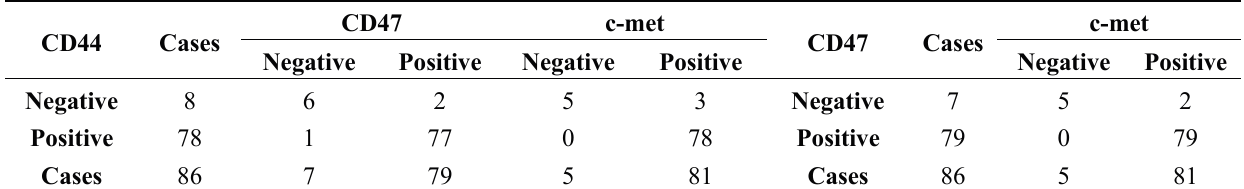
Table 4. The correlation between CD44, CD47 and c-met expression in